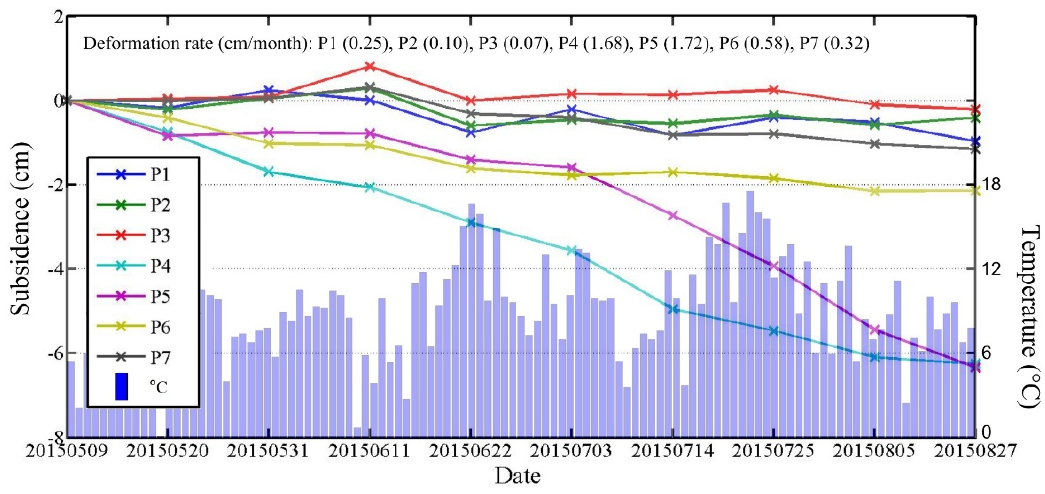
Figure 9. The time ‐ series accumulated subsidence at point P1 to P7 with ground temperature data. Points P1, P2, P3 and P7 were located in the stable area (i.e., the green region in Figure 5) with a